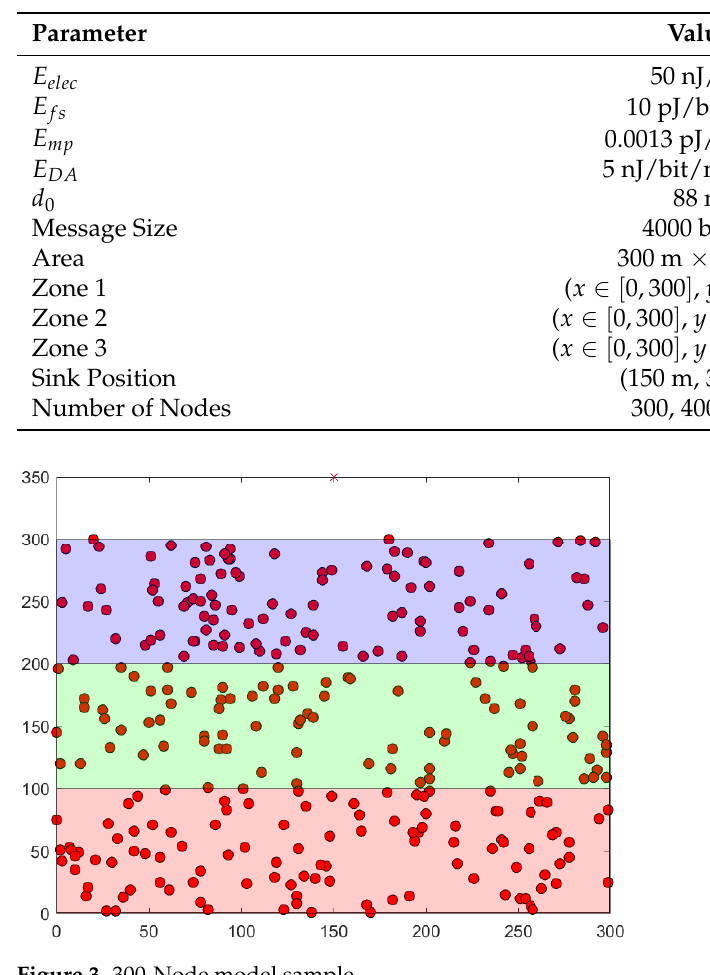
Table 2. Simulation parameters.